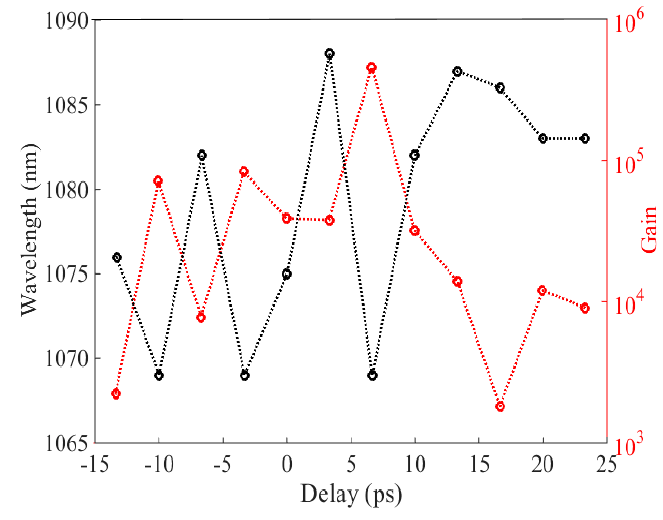
Figure 7. Maximum gain value (red circles) and its corresponding signal wavelength (black circles) as a function of the delay.